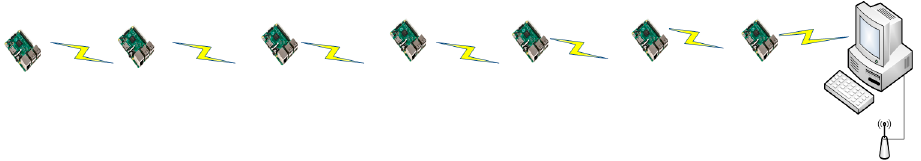
Figure 3. Network architecture.